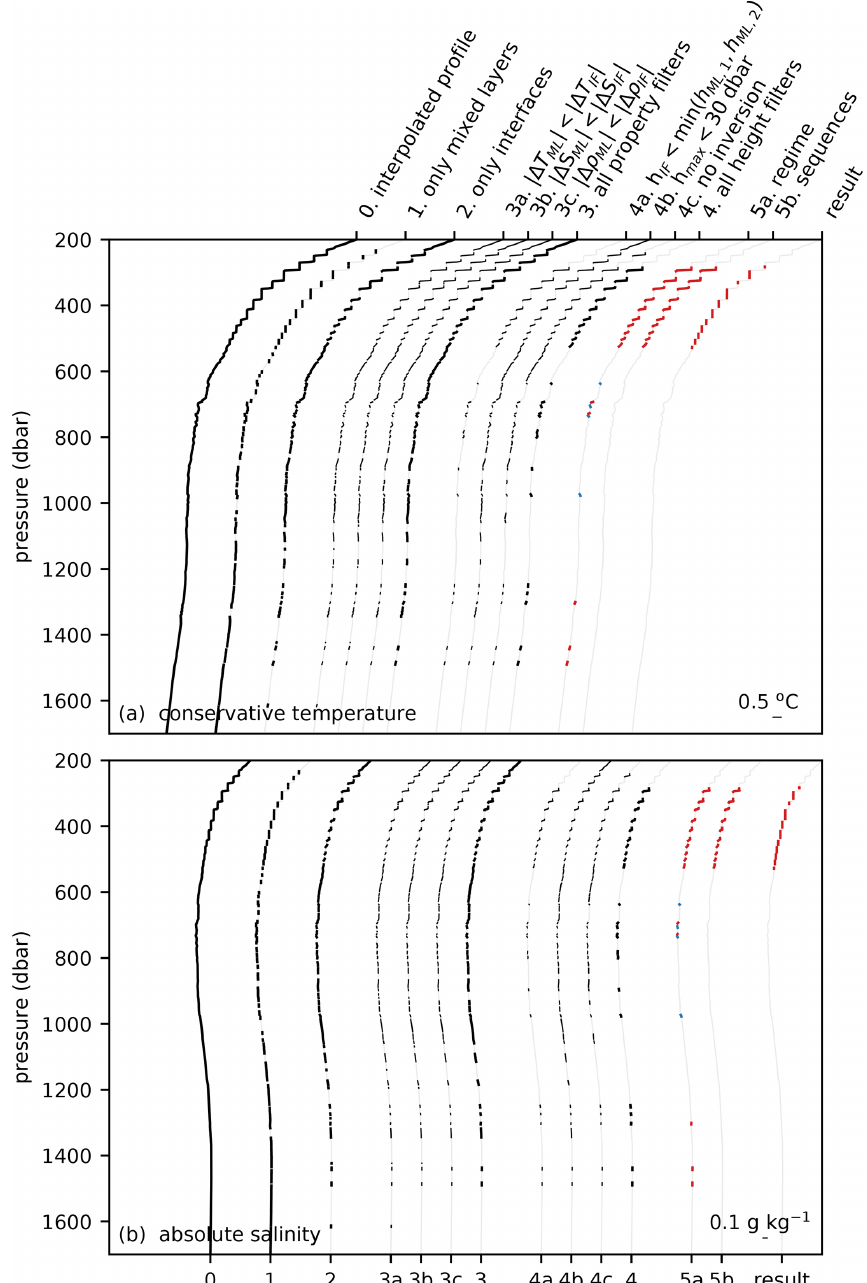
Figure A3. As Fig. A1, but for a profile in the western tropical North Atlantic. Original profile is taken from Argo float 4901478 at 53.3 ◦ W and 11.6 ◦ N on 9 August